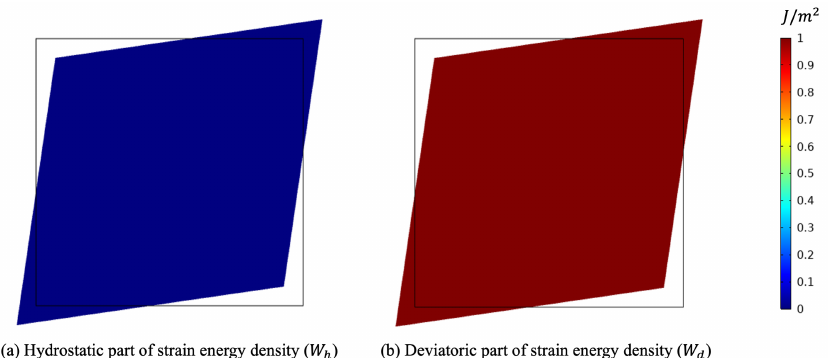
Figure 7. Deformed shape for the pure deviatoric case (plots were obtained with a scale factor of 20).